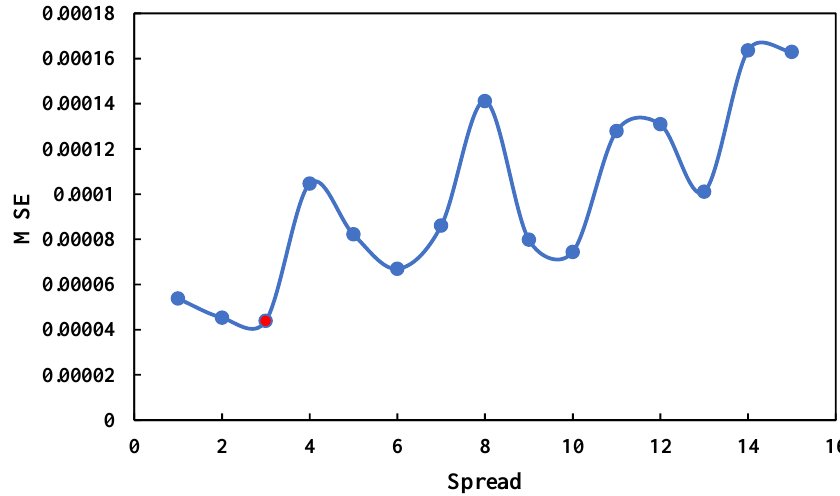
Figure 8. Optimization Spread parameter in RBF network .